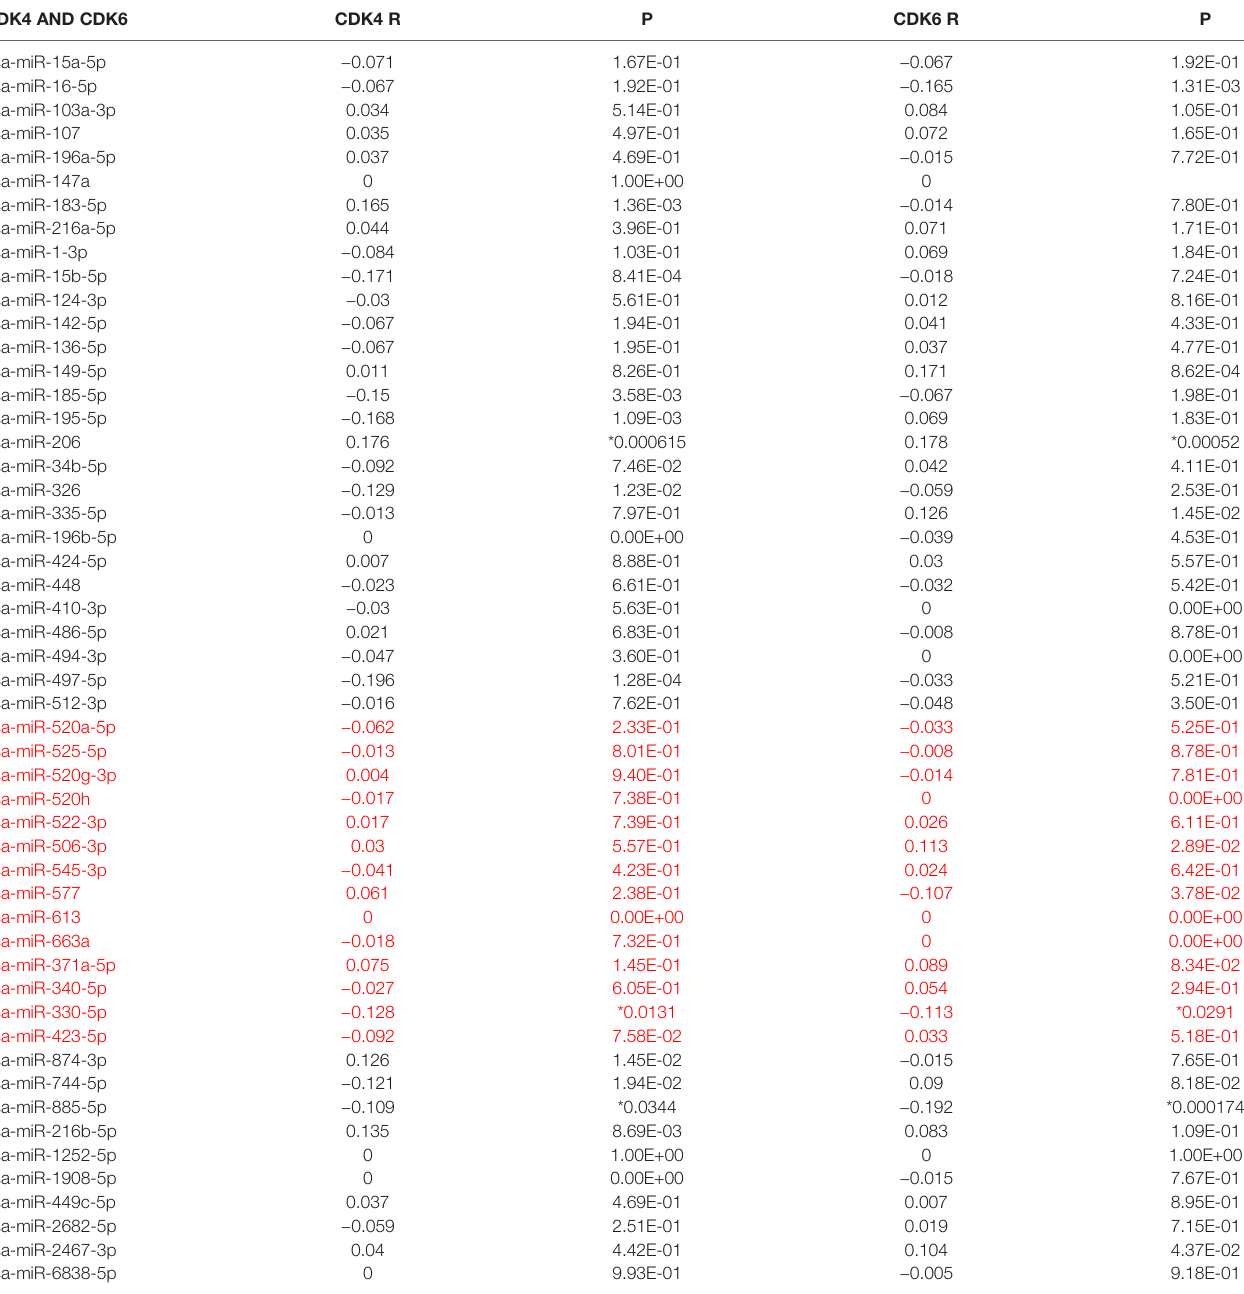
TABLE 1 | Correlation analysis between has-mir-330-5p and CDK4/6 in OV determined by starBase database. CDK4 AND CDK6 CDK4 R P CDK6 R